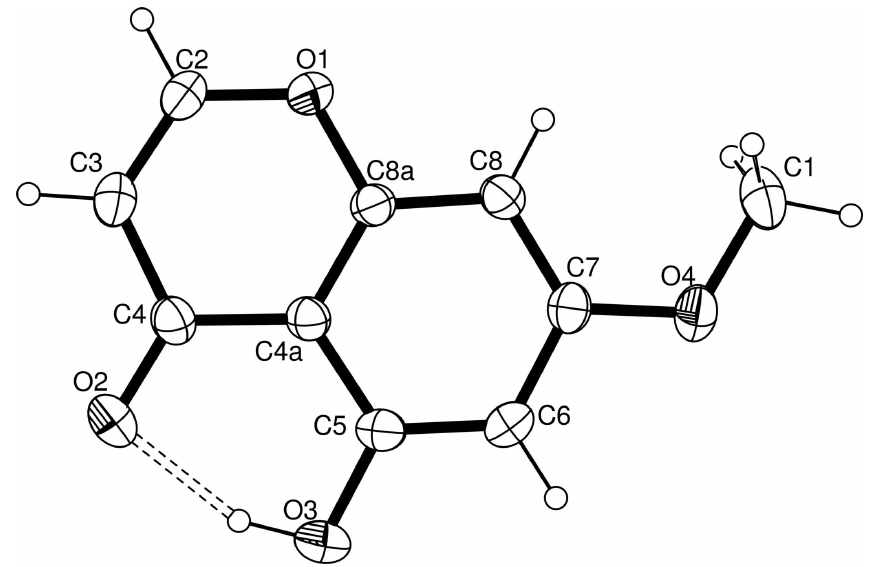
The molecular structure of the title compound, showing the atom-numbering scheme. Displacement ellipsoids are draw at the 30% probability level. The dashed line indicates the intramolecular O–H···O hydrogen bond. H atoms are shown as small spheres of arbitrary